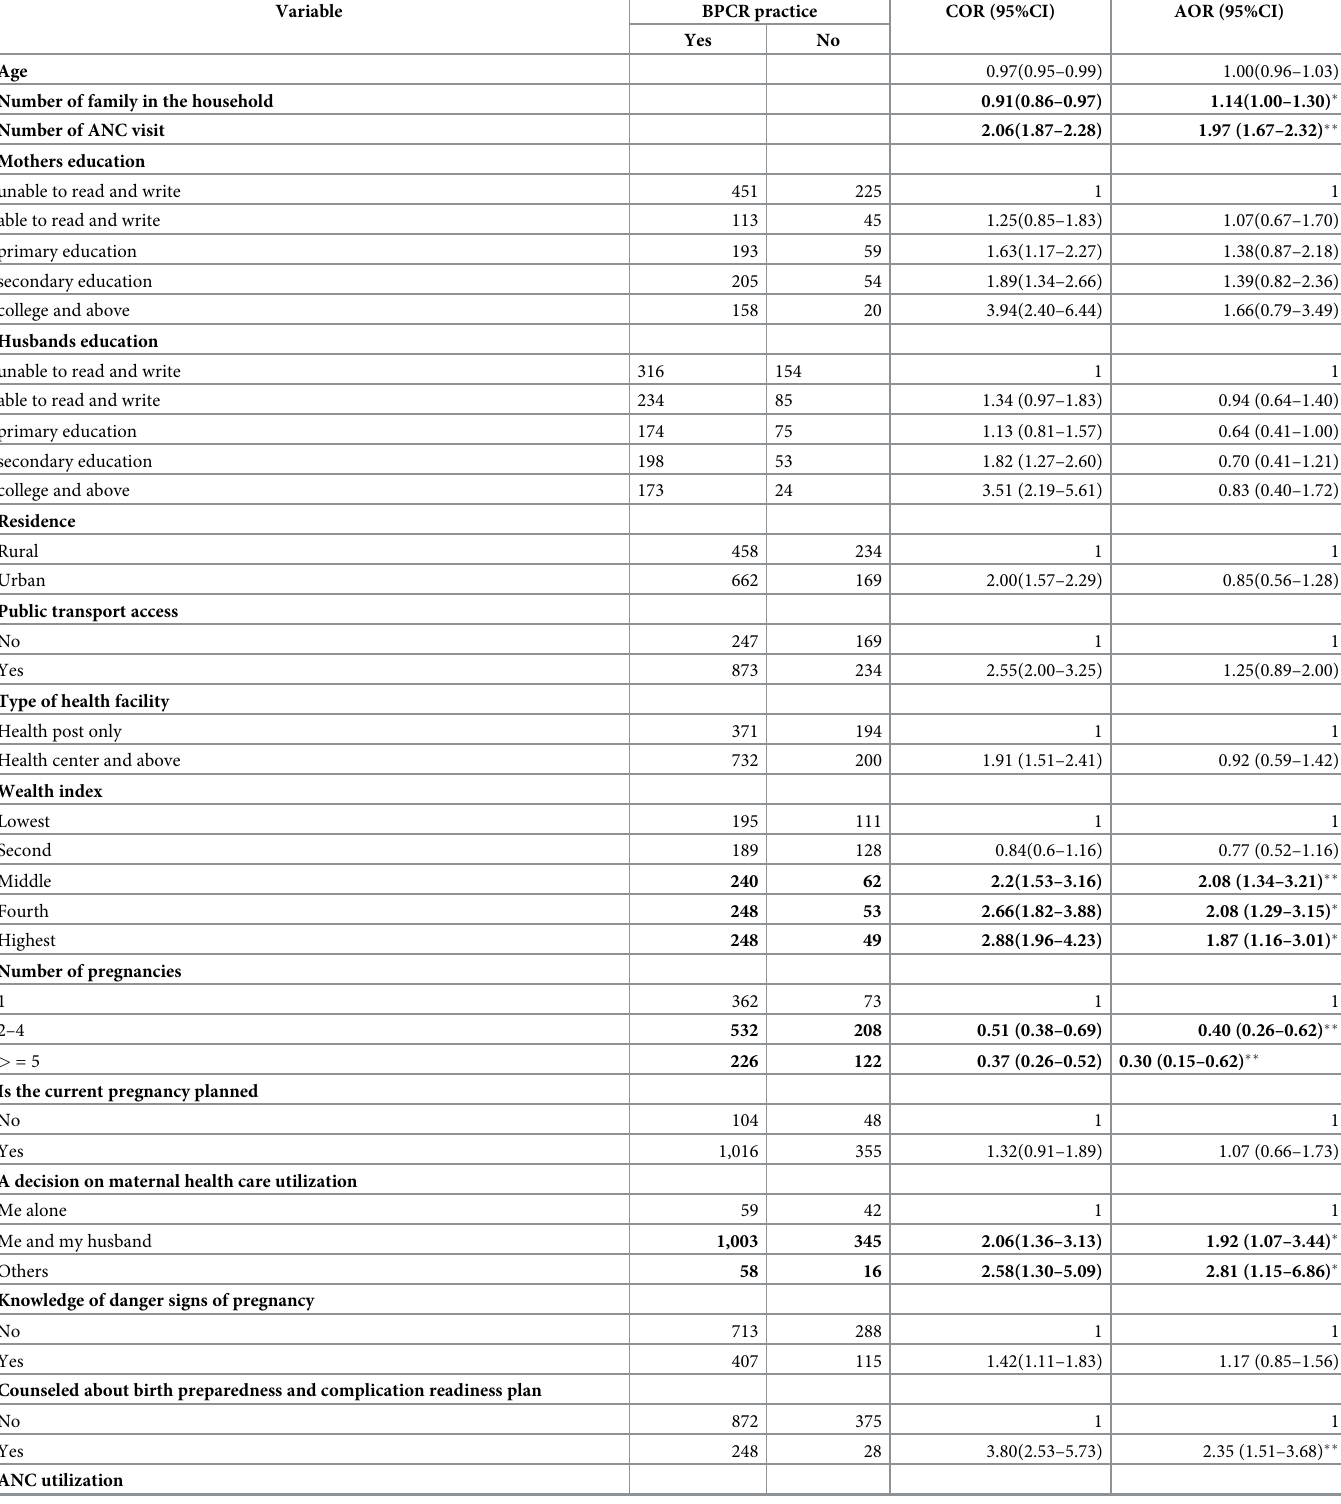
Table 4. Bivariate and Multivariate analysis of factors associated with BPCR Practice among pregnant women, North Gondar Zone, Northwest Ethiopia, 2018.